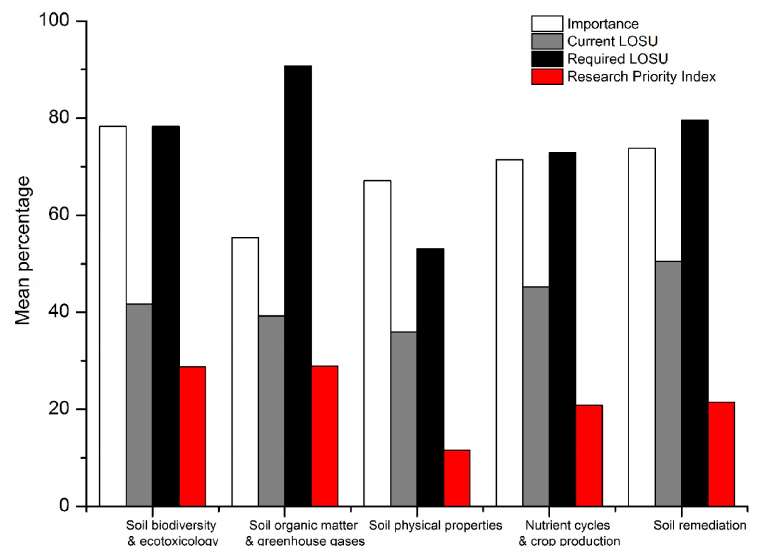
Fig. 1. Differences between thematic groups in the mean values for research priority index and its partitions: Importance, current and required level of scientific understanding (LOSU), and research priority index of individual thematic